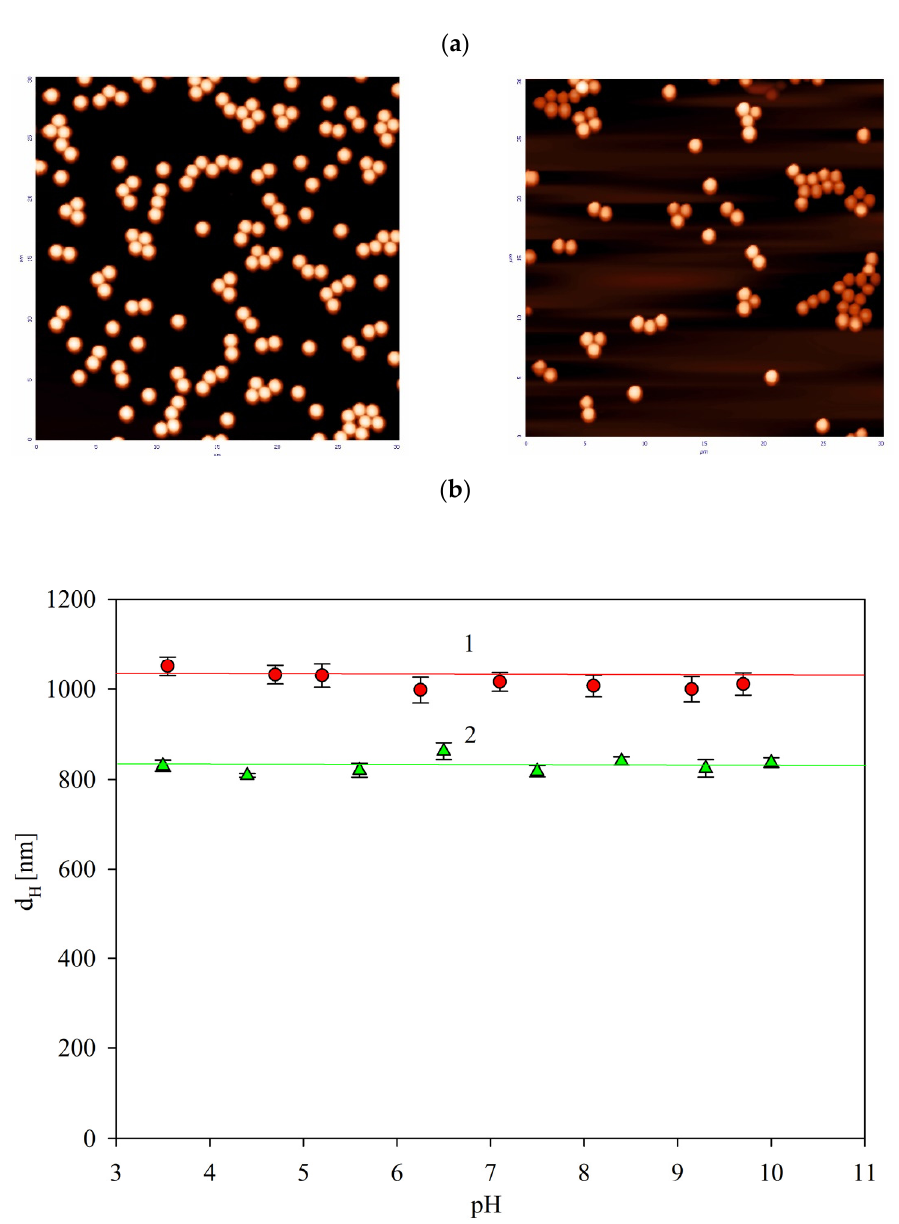
Figure 1. ( a ) The AFM images of the bare polystyrene particles (L800), left hand side, and the salmonella immunolatex particles (SAL), right hand side (scale 30 µ m × 30 µ m). ( b ) Dependencies of the hydrodynamic diameter of the particles on pH determined by the Stokes–Einstein equation using the DLS diffusion coefficient data, 1 mM NaCl. 1. SAL particles, bulk concentration 100 mg L − 1 ; 2. L800 particles, bulk concentration 100 mg L − 1 . The lines are guides for the eyes.